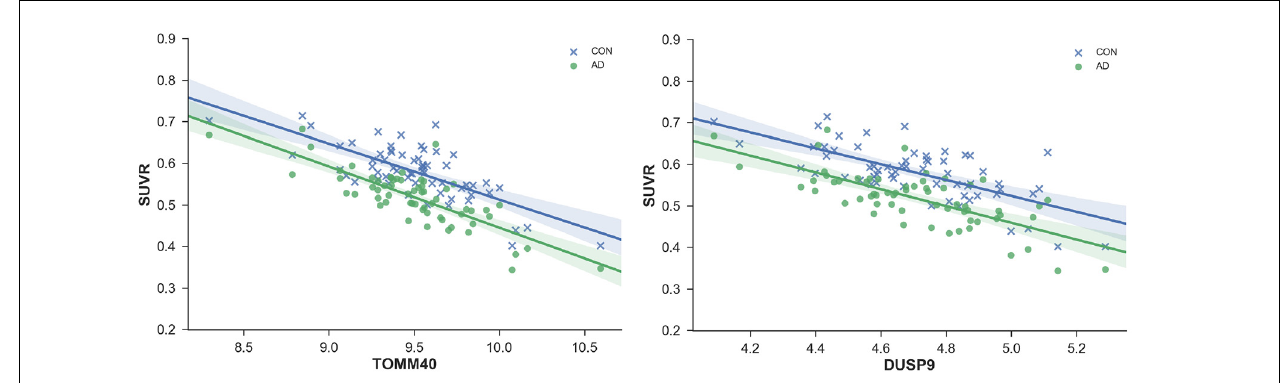
FIGURE 2 | Standardized values (SUVR) plotted against regional gene expression for genes with most significant correlations; TOMM40 and ANKH. Each point represents a region of the Desikan–Killiany (DKT)